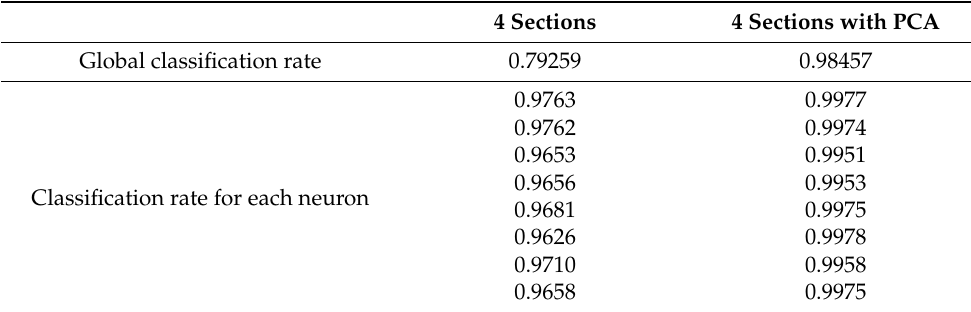
Figure 11. Classification results obtained for a network branch with five cable sections: ( a ) Global classification rate ob- tained during the test and training phase by using a dataset with four frequencies; ( b ) Global classification rate obtained during the test and training phase by applying the principal component analysis to a dataset with 100 frequencies.